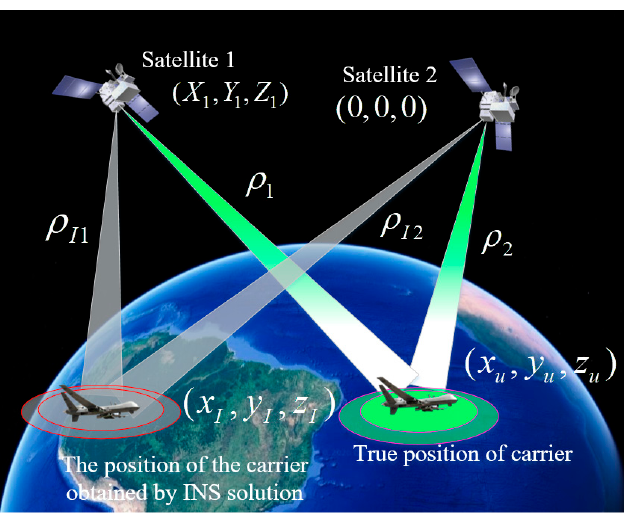
Figure 5. Schematic diagram of the INS+LEO 1 satellite + altimeter tightly integrated navigation algorithm.